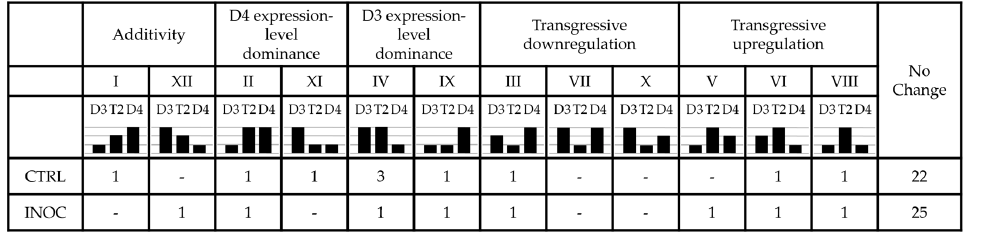
Table 1. Expression patterns for nodulation-related genes from Schmutz et al. [45]. The twelve categories represent possible patterns of differential expression in the allopolyploid relative to its diploid progenitors, and have been adapted from [45]. For pairwise comparisons, control (‘CTRL’) and inoculated (‘INOC’) samples were analyzed separately.